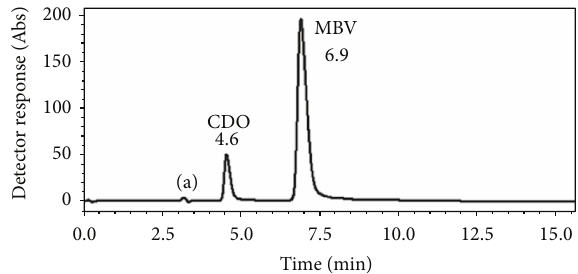
Figure 4: Representative chromatogram obtained for simultaneous determination of CDO (5.0 𝜇 g/mL) and MBV (135.0 𝜇 g/mL) in coformulated Coloverin A tablets, where (a) is the solvent